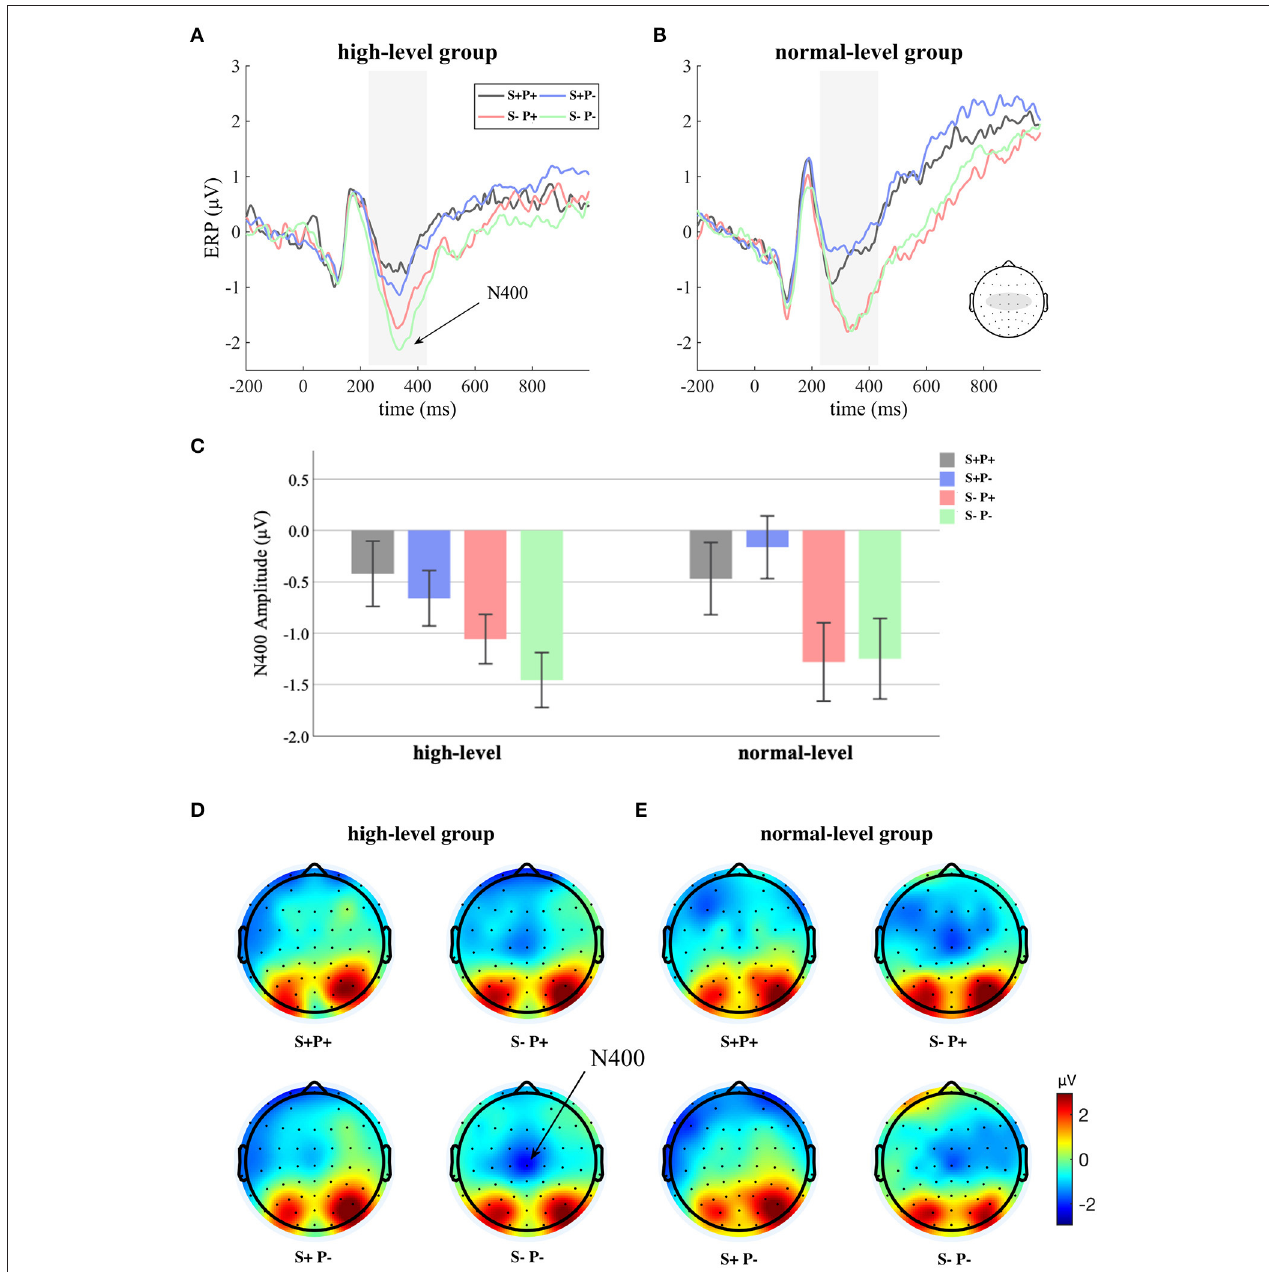
FIGURE 2 | (A,B) The grand-averaged ERP waves; (C) the N400 amplitude (error bars indicate standard error); (D,E) the scalp topographies of